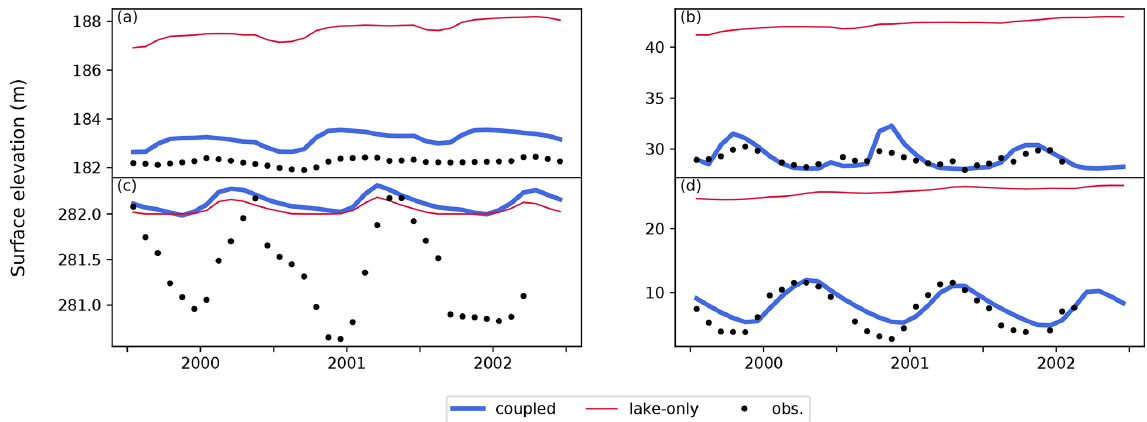
Figure 9. Time series of monthly mean values of lake surface elevation ( m ) for (a) Lake Superior, (b) Lake Champlain, (c) Lake Chad, and (d) Lake Tonlé Sap (HydroLAKES ID 5, 64, 15, and 153, respectively). Black dots show observed values, and blue (red) lines show values calculated by the coupled (lake-only)